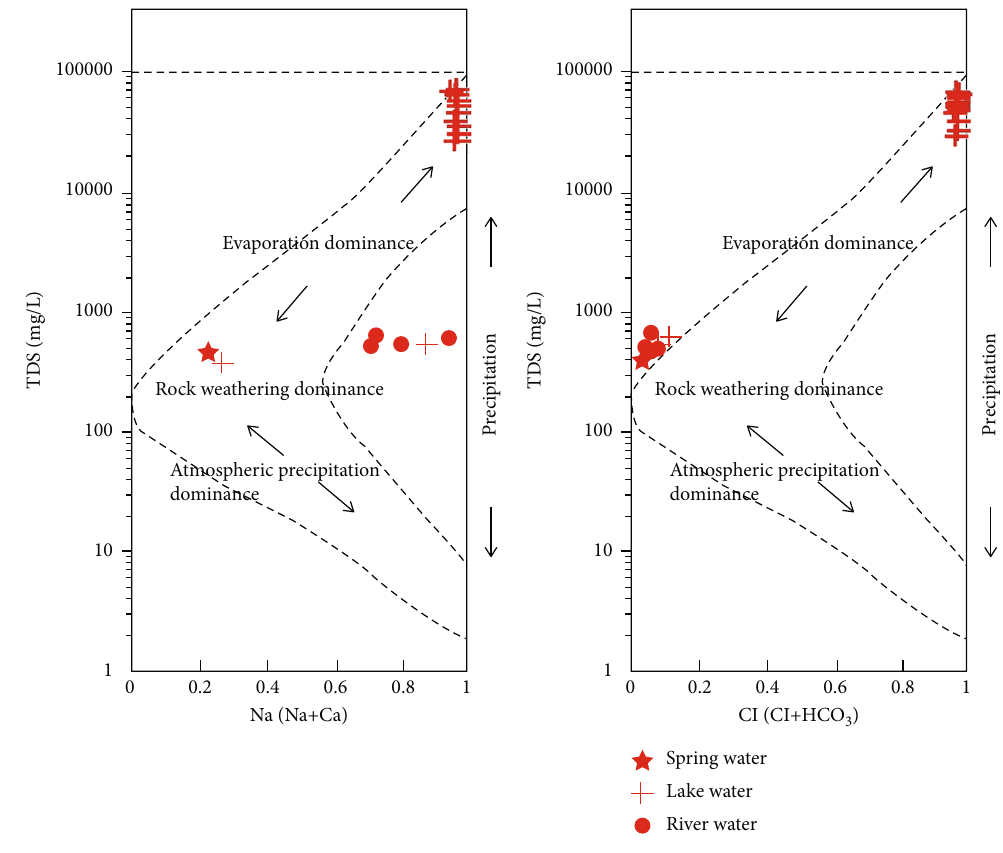
Figure 4: Gibbs ’ diagram of the Lakkor Co region.